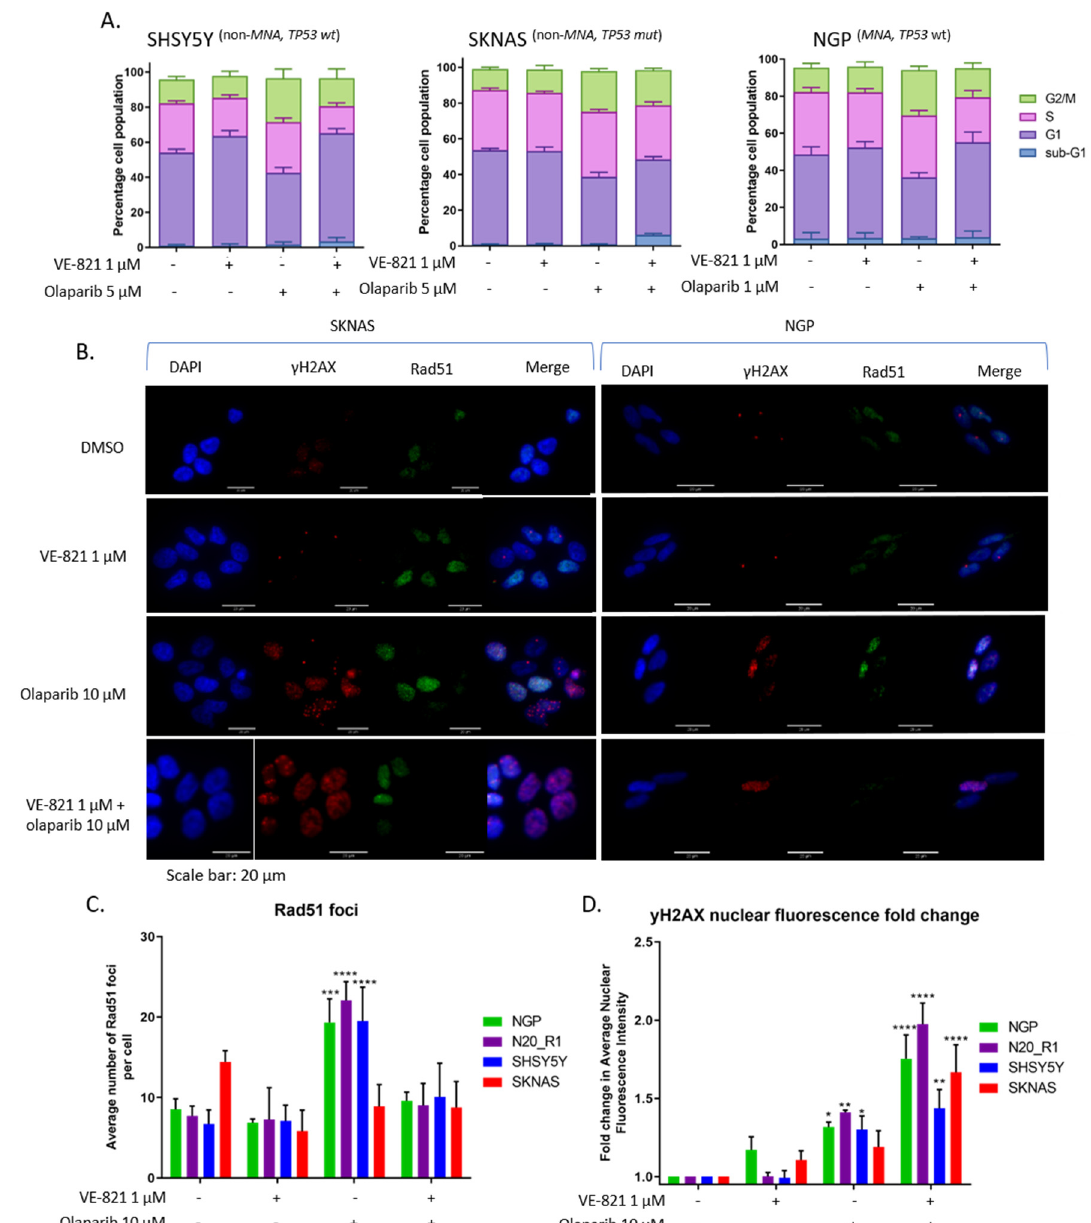
Figure 5. E ff ect of VE-821 and olaparib combination on cell cycle and homologous recombination repair (HRR). ( A ) Cell cycle analysis of SHSY5Y, SKNAS and NGP cell lines treated with 5 µ M (SHSY5Y and SKNAS) or 1 µ M (NGP) olaparib in combination with 1 µ M VE-821 for 24 h. Data are mean + SEM from 3 independent experiments. ( B ) Representative γ H2AX and Rad51 foci images from SKNAS and NGP cell lines treated with 1 µ M VE-821, 10 µ M olaparib or both for 24 h. ( C ) Average number of Rad51 foci per cell for NGP, N20_R1, SHSY5Y and SKNAS cell lines treated with 1 µ M VE-821, 10 µ M olaparib or both, n = 4 + sd. ( D ) Average γ H2AX nuclear fluorescence intensity for NGP, N20_R1, SHSY5Y and SKNAS cell lines treated with 1 µ M VE-821, 10 µ M olaparib or both, fold change from control (DMSO), data are mean + SEM from 4 independent experiments. * p ≤ 0.05, ** p ≤ 0.01, *** p ≤ 0.001, **** p ≤ 0.0001, 2-way ANOVA di ff erence from control (DMSO).